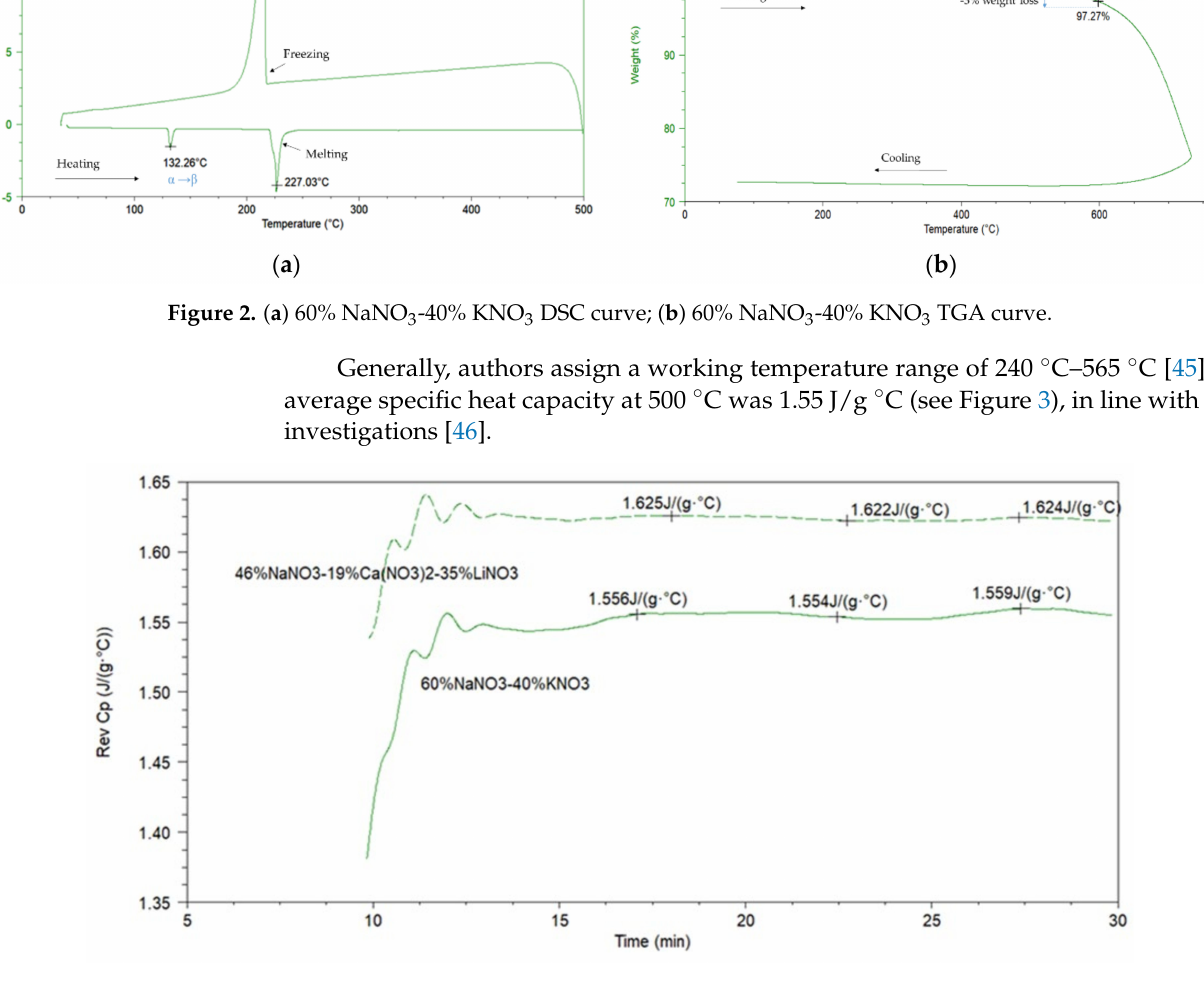
Figure 3. Specific heat capacity of the molten salts studied at 500 ◦